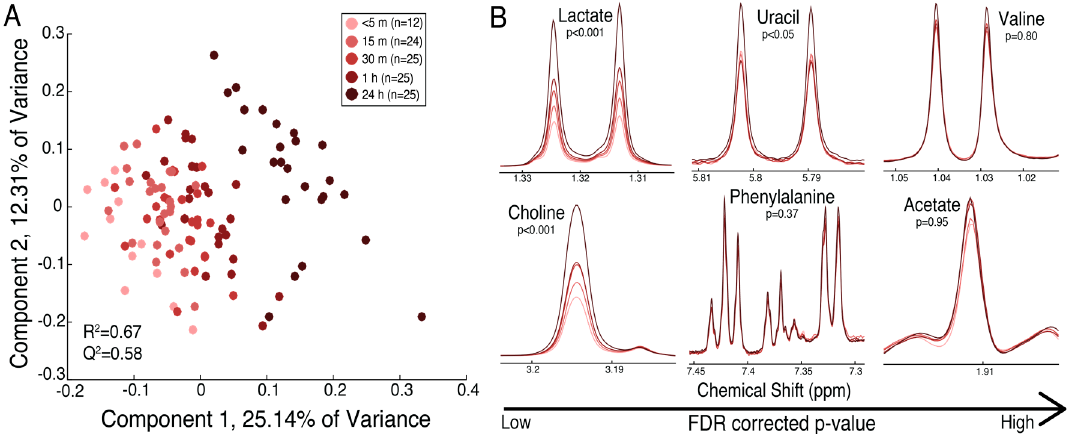
Figure 4. ( A ) The PLS-DA scores plot reveals separation of the specimens from the fetal surface of the placenta from 13 placentas at five time points postdelivery: (1) <5 min ( n = 12), (2) 15 min ( n = 24), (3) 30 min ( n = 25), (4) 1 h ( n = 25), and (5) 24 h ( n = 25). The time points are represented as varying shades of red, from light (<5 min) to dark (24 h); ( B ) mean spectra of time points displaying metabolites with varying significance of FDR-corrected p -values from left to right (low to high). Lactate, choline, and uracil significantly increased over time ( p < 0.001), while phenylalanine, valine, and acetate did not show a significant trend over 24 h. Table 3 displays the means with standard errors, FDR-corrected p -value, and fold change between <5 min and 1 h following delivery for all metabolites identified. Table 3. Metabolites abundance over 24 h on the surface of the fetal placenta.